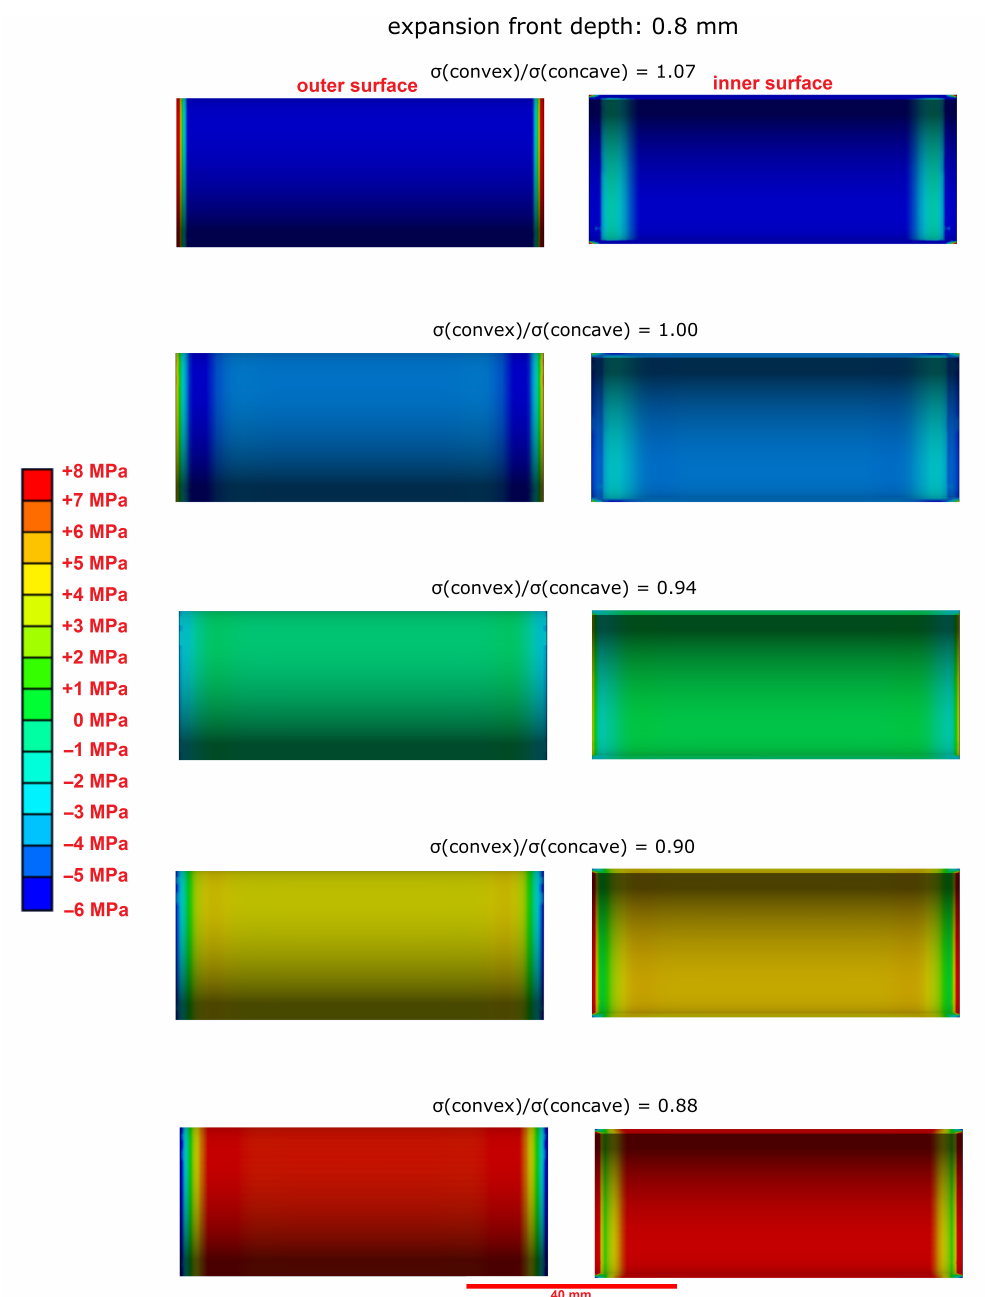
Figure 12. Modelled stress distribution (finite element model, first main tension) in the undamaged in- ner core over the length of a hollow cylinder that is exposed to expansion stress ( σ (concave) = 8.0MPa). ( Left ): at the outer surface, ( Right ): at the inner surface of the cylinder. The expansion front depth of the ettringite formation was set to 0.8mm. A slightly larger expansion stress beneath the concave inner surface leads to tensile stress within the sample’s core that can exceed its tensile